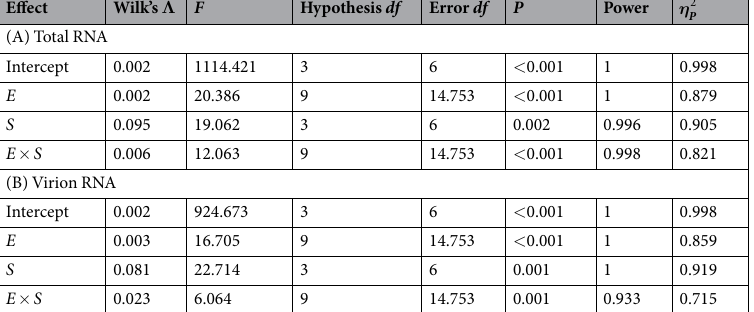
Table 4. Results of the MANOVA analysis for the RNA frequencies estimated from total and from virion RNA extractions in experiments with 1:1:1 input rations done in wildtype and P1, P2 and P12 transgenic N. benthamiana . The model fitted is shown in equation (3). E : N. benthamiana genotype; S : sample type; E × S : plant genotype by sample type interaction